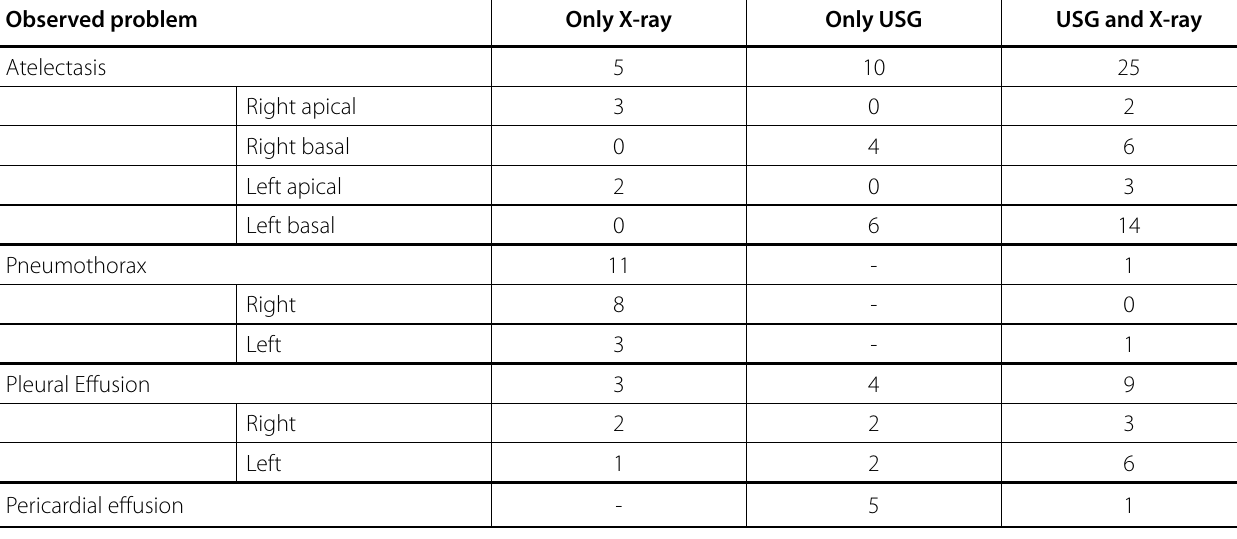
Table 2. The evaluation of chest X-ray and USG of the pathologies. Observed problem